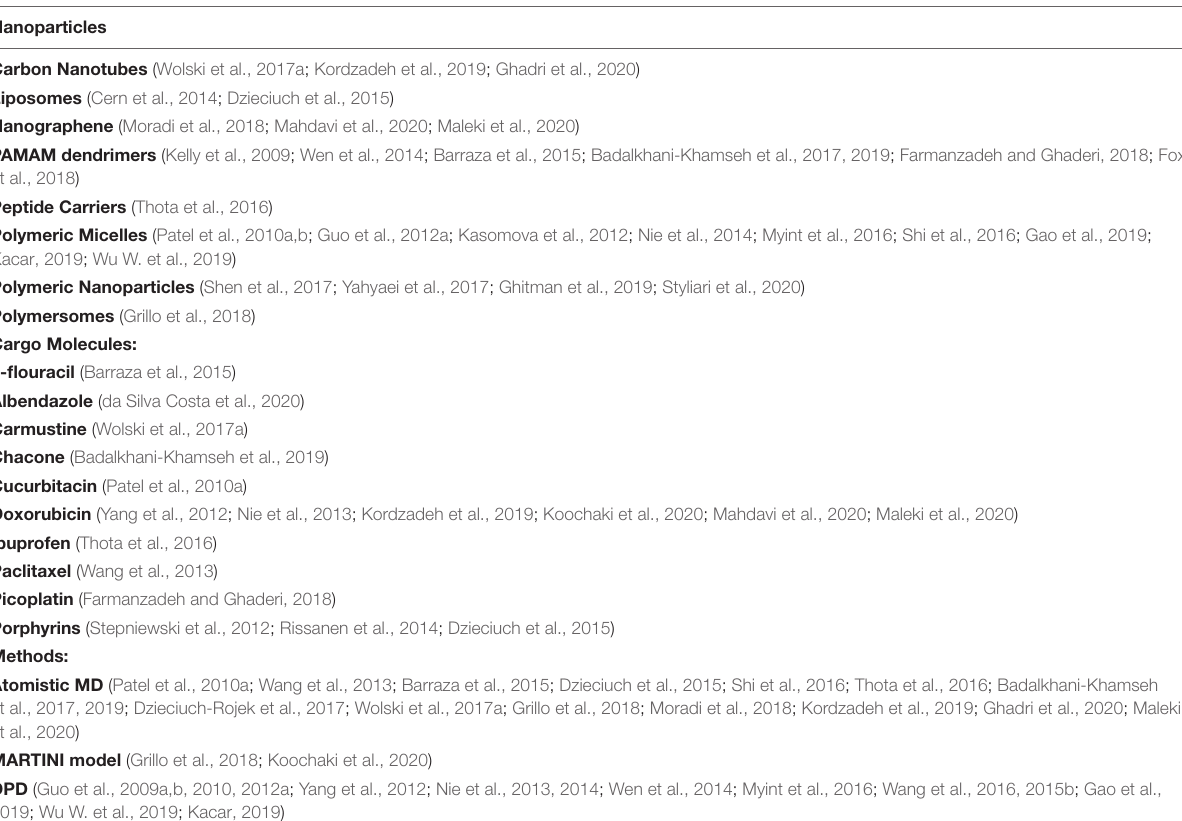
TABLE 4 | Nanoparticles, cargo molecules, and methods used to study drug loading and release.